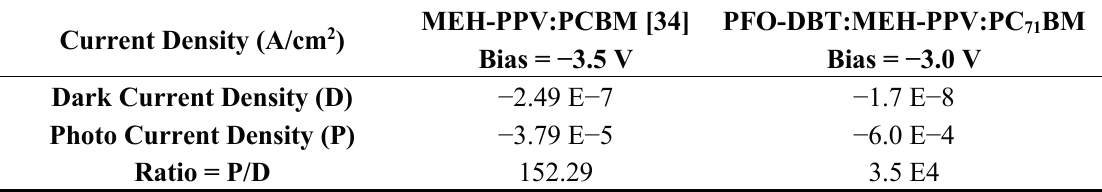
Table 2. Comparison of the binary and ternary blend based sensor’s parameters at reverse